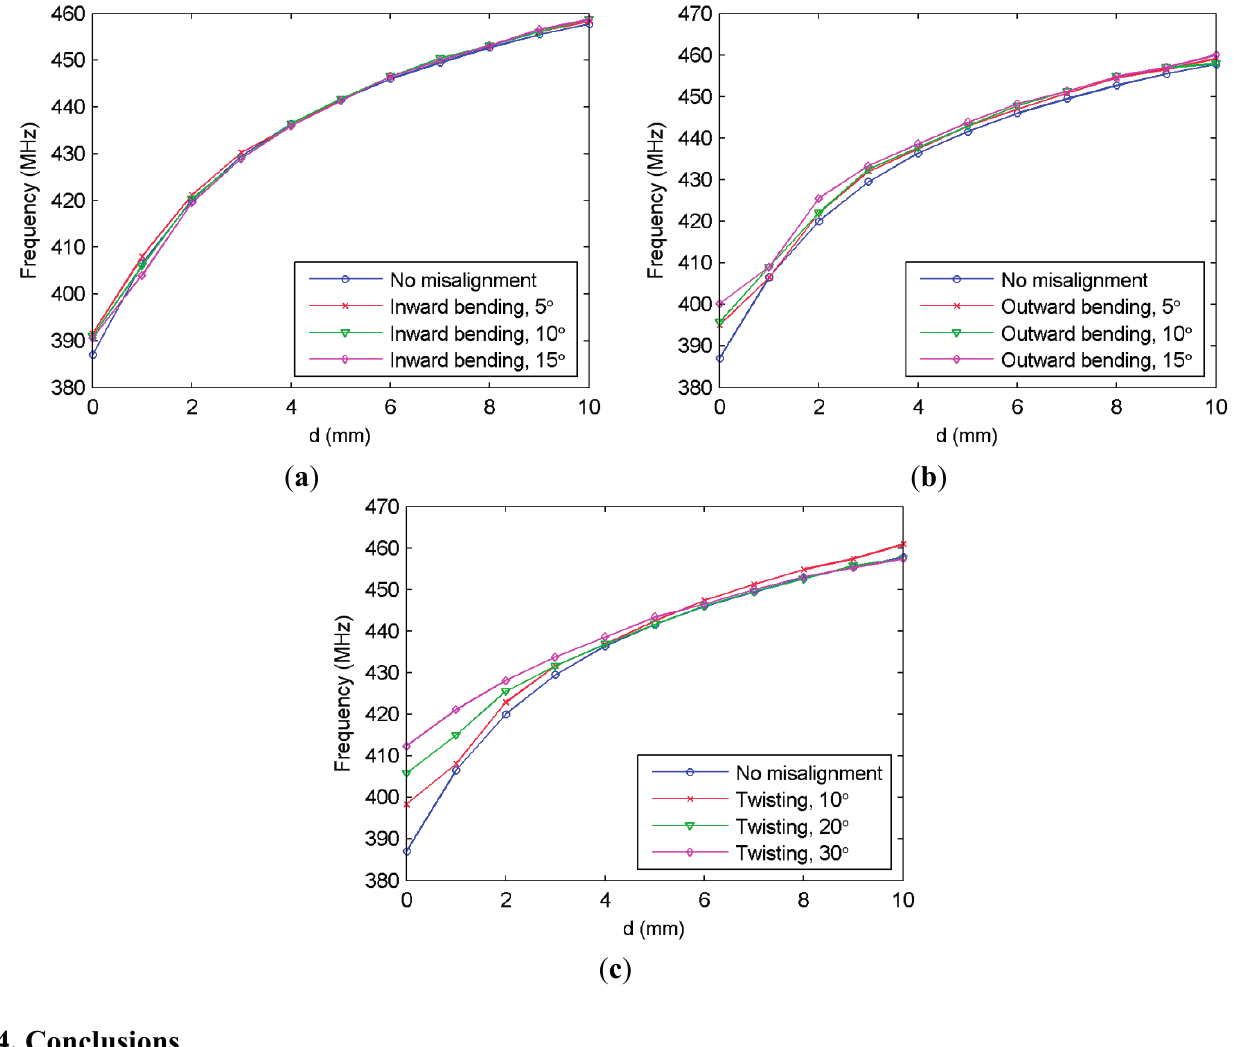
Figure 6. Shifting frequency of the metamaterial-based sensor versus displacement using the data experimentally obtained for possible misalignments: ( a ) inward bending of the NSRR parts, given for the angles of 5°, 10° and 15°; ( b ) outward bending of the NSRR parts, given for the angles of 5°, 10° and 15°; ( c ) twisting of the NSRR parts, given for the angles of 10°, 20° and